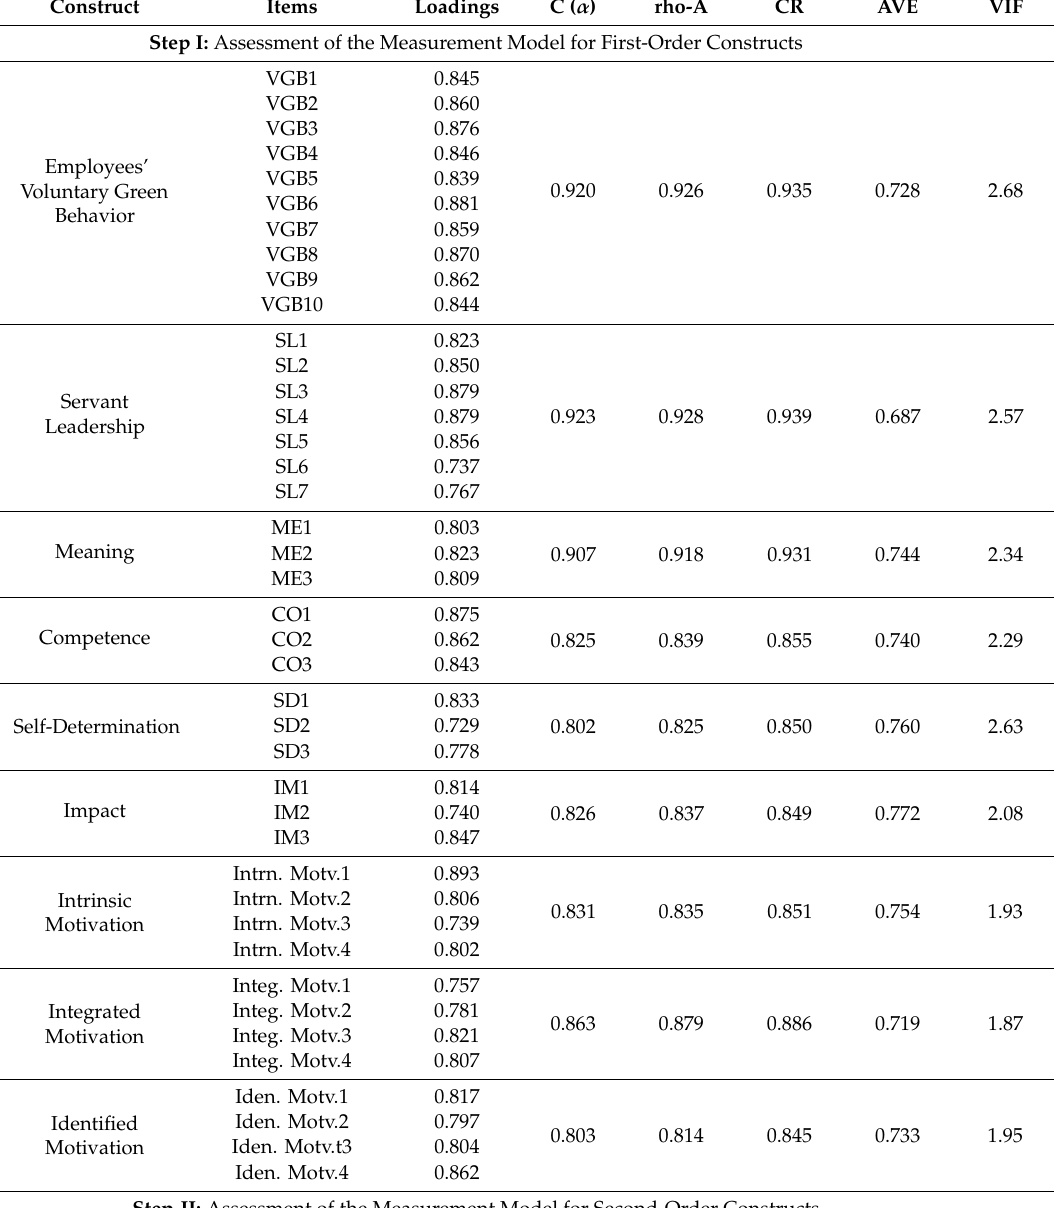
Table 2. Results of the measurement